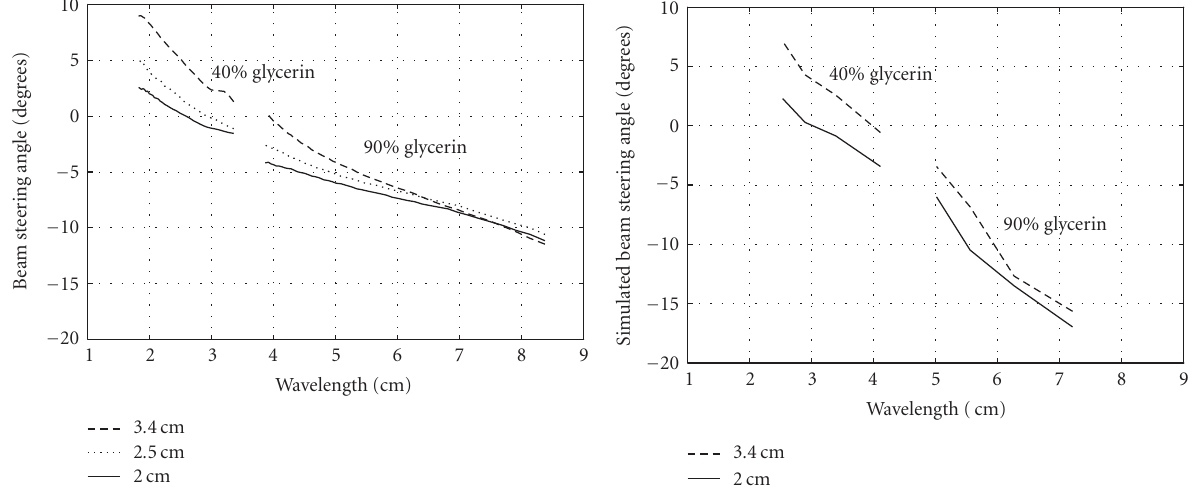
(b) Same as Figure 8(a) for simulation results of beam steering angles for the 2.0 and 3.4cm length monopole antennas operating in the 90% and 40% glycerin: water baths